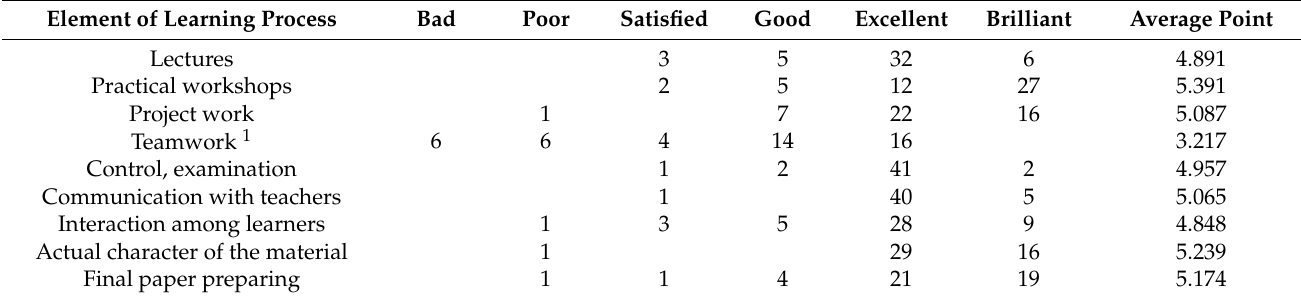
Table A1. Points awarded by students on the elements of the organization of the educational process, July 2020 (N1 = 46). Element of Learning